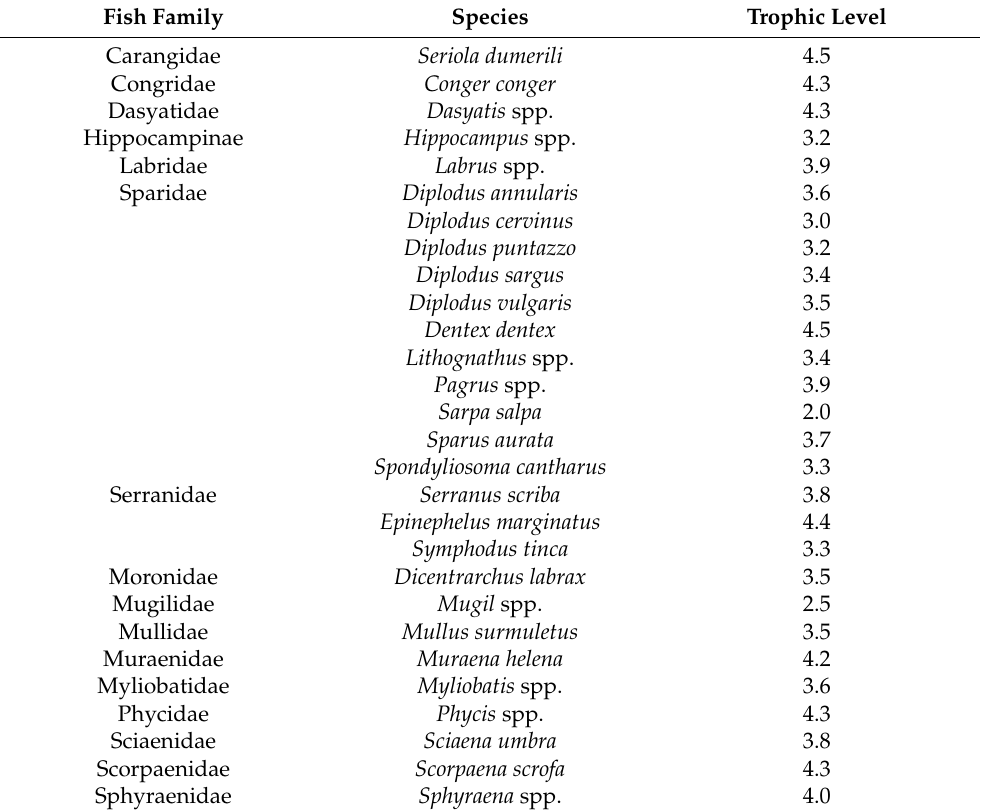
Table 1. List of species selected during the FAST sampling and trophic category (from